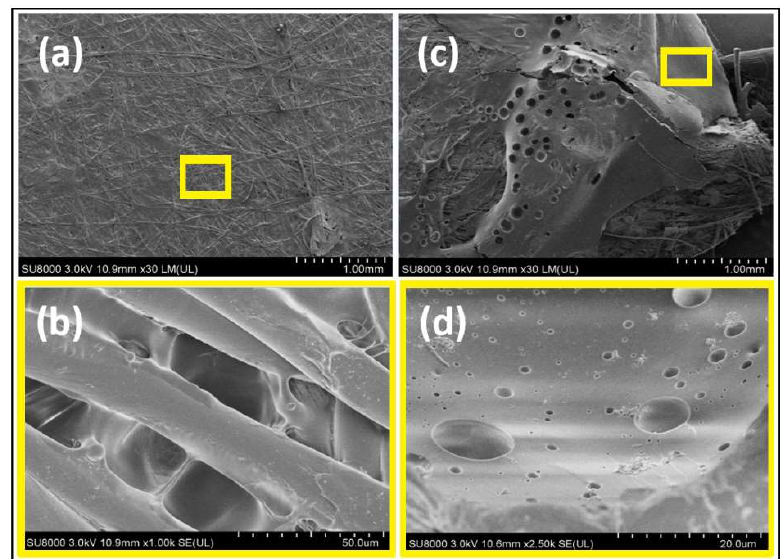
Figure 4. SEM micrographs of pristine PVDF and zwitterionic-polymer-modified PVDF membranes. ( a ) pristine PVDF membranes ( b ) microporous structures of pristine PVDF membranes ( c ) zwitterionic-polymer-modified PVDF membranes ( d ) microporous structures of zwitterionic-polymer-modified PVDF membranes.